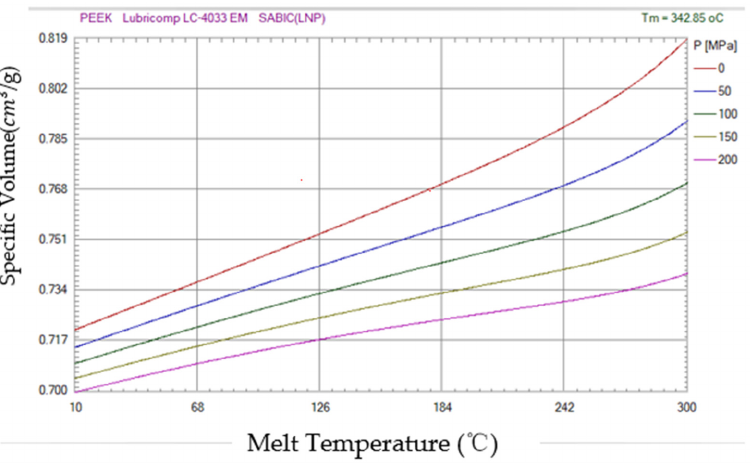
Figure 2. PVT diagram of PEEK material.